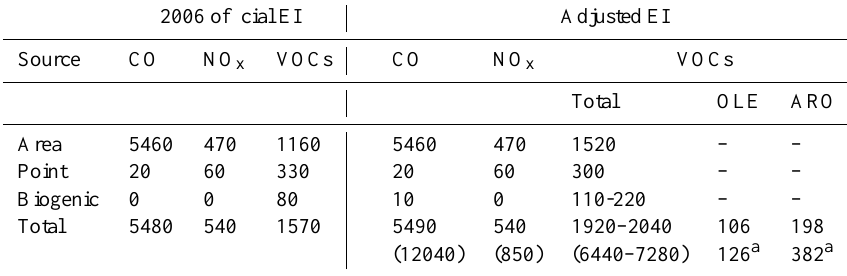
Fig. 5. Comparison of hourly simulated concentrations of O 3 with the observations averaged over 15 RAMA monitoring sites during (a) O 3 -SV, (b) O 3 -N1, (c) O 3 -S, (d) O 3 -N2, (e) O 3 -CnvS, and (f) O 3 -CnvN episode. Shaded area and error bars indicate ± 1 standard deviation of the observation and simulation, respectively. Table 2. Comparison between total weekday emissions by pollutant type and source category in the MCMA from the 2006 official emission inventory and the adjusted emissions used in this study. Units are in tons day − 1 . Numbers in parenthesis indicate the domain-wide